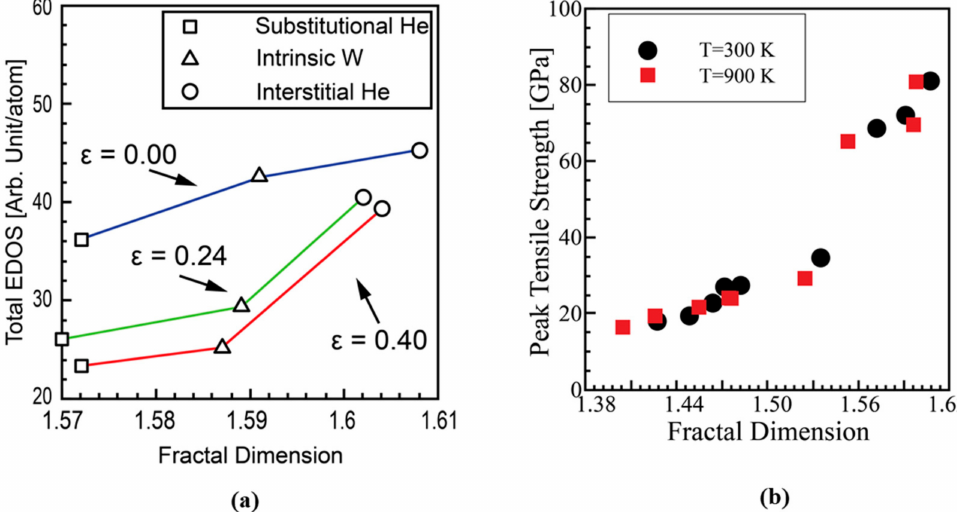
Figure 3. Ab initio simulation results of uniaxial tensile tests of W nanostructures reproduced from [22]. ( a ) Correlation between fractal dimension and total electron density of states (EDOS); ( b ) correlation between fractal dimension and peak tensile strength of W grain